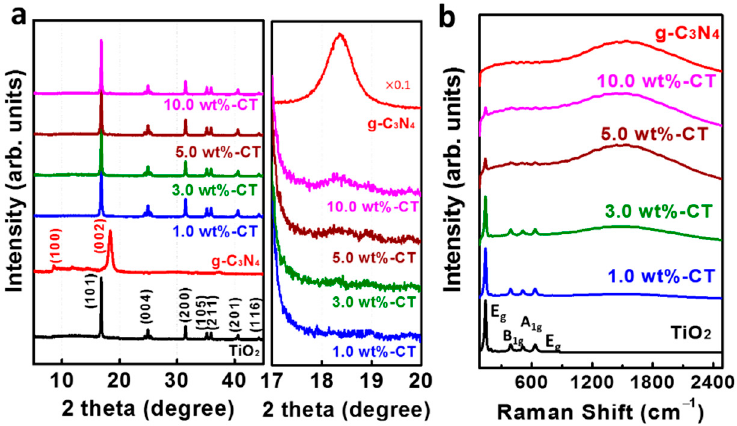
Figure 1. ( a ) Synchrotron X-ray spectra and ( b ) Raman spectra of the various g-C 3 N 4 /TiO 2 cata-